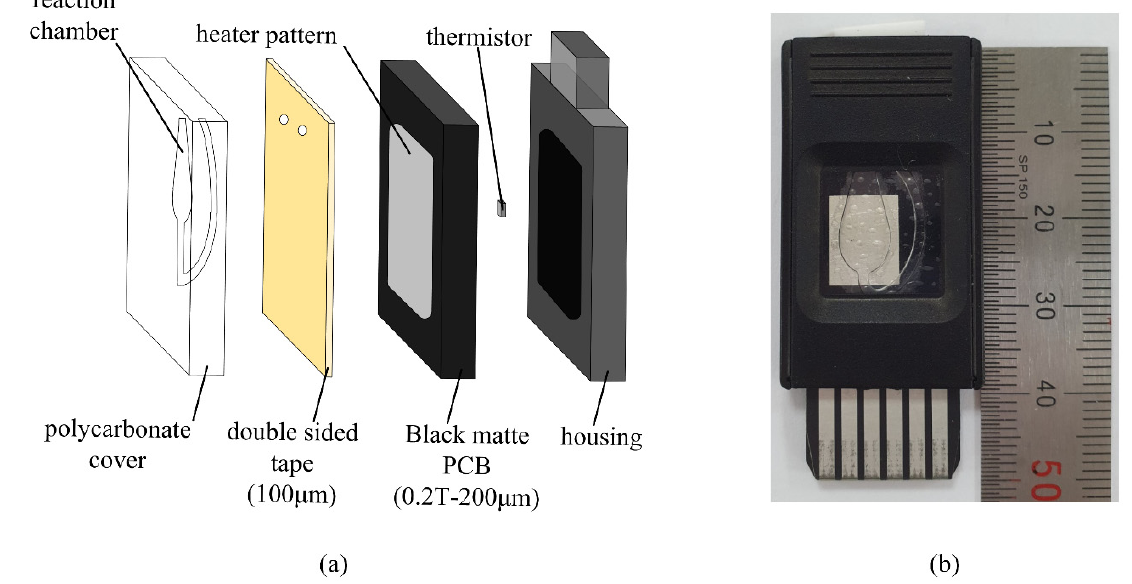
Figure 1. Schematic and actual PCR chip used in this study. ( a ) Schematic; ( b ) Photo of the actual PCR chip.